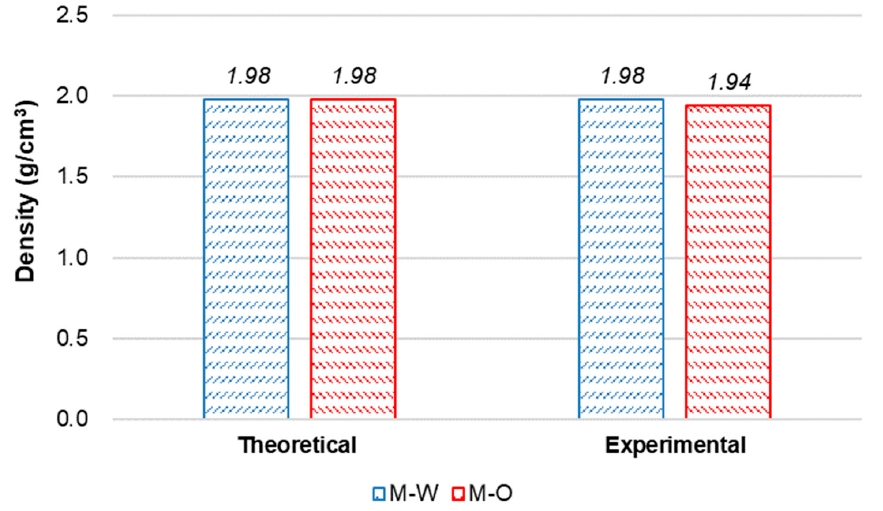
Figure 2. Theoretical and experimental densities of SHCC.